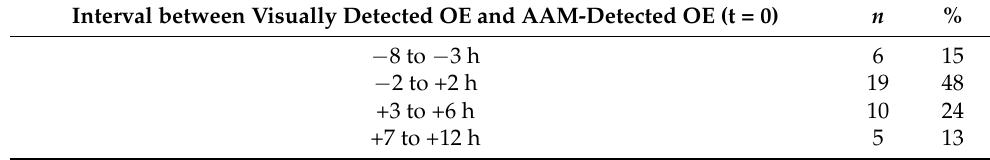
Table 2. Distribution of lactating cows based on time interval between visual detection and automatic activity monitoring (AAM) detection of onset of estrus (OE) 1